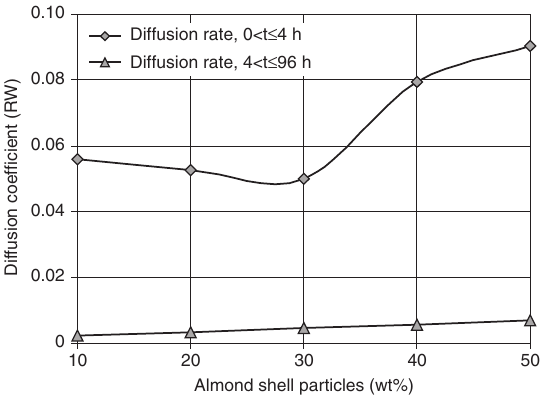
Figure 8 Diffusion coefficient of different weight percentages of almond shell particles in RW.